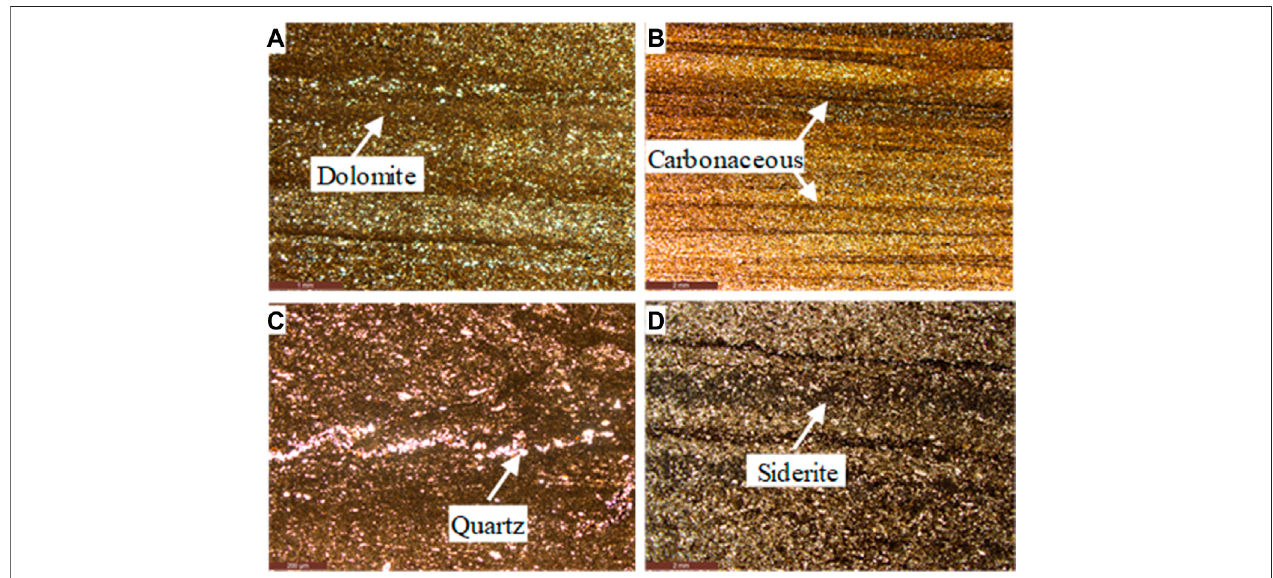
FIGURE4| ImagesoftheLucaogou FormationshalesamplesoftheDongdalongkousection. (A) Thesampleismainlycomposedofscalyargillaceous,5%micro- cryptocrystalline dolomite, 2% carbonaceous component, and 3% silty sand. (B) The composition is mainly scaly argillaceous, 6% iron dolomite, 4% carbonaceous component, and 4% silty sand. The carbonaceous material is linearly distributed along the bedding, and the silty sand is mainly quartz, feldspar, and other particles. (C) The rock composition is mainly scaly argillaceous, 40% carbonate, and 7% silt, and the silt is unevenly distributed. Carbonate is mainly composed of calcite and siderite,bothofwhicharecryptocrystallineanddif fi culttodistinguish.Siltismainlycomposedofquartz,feldspar,andotherparticles. (D) Therockhasavery fi ne-grained sandy structure. The particle composition is mainly feldspar, a small amount of rock debris, and quartz. It can be seen that 2% of peat is distributed in strip and bedding orientation. Intergranular interstitial material is mainly carbonate, accounting for 10%, and a small amount of argillaceous material, accounting for 2%. The carbonate components are mainly siderite and a small amount of calcite. Siderite is distributed in petal and spherical shapes, and calcite microcrystalline structure.